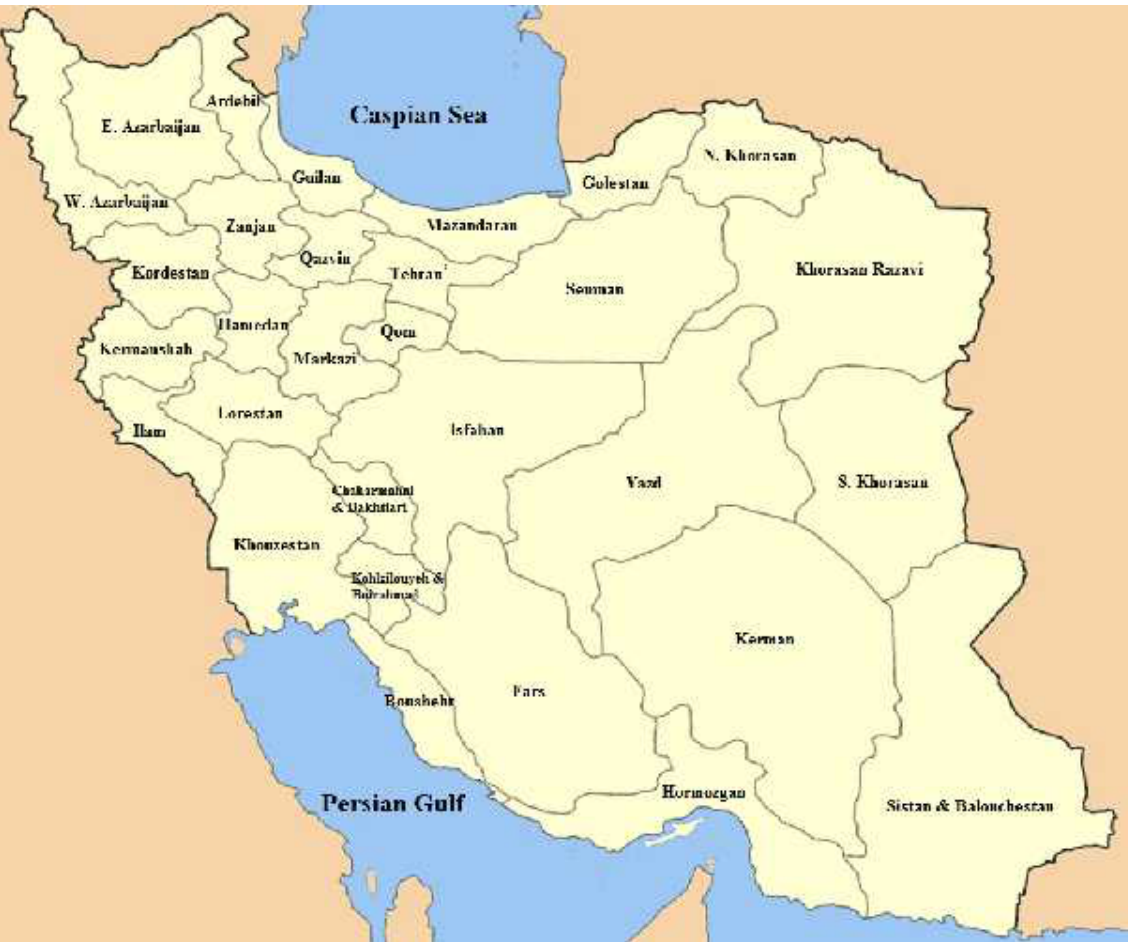
F IGURE 1. Map of provinces of Islamic Republic of